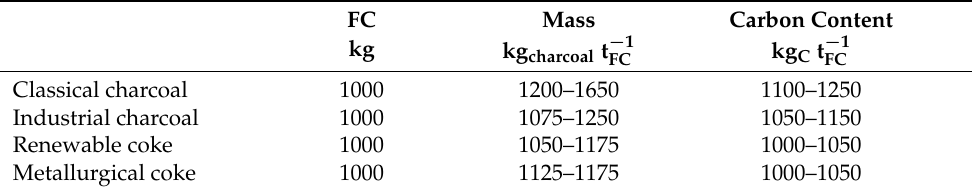
Table 7. Carbon materials in relation to the functional unit (fixed